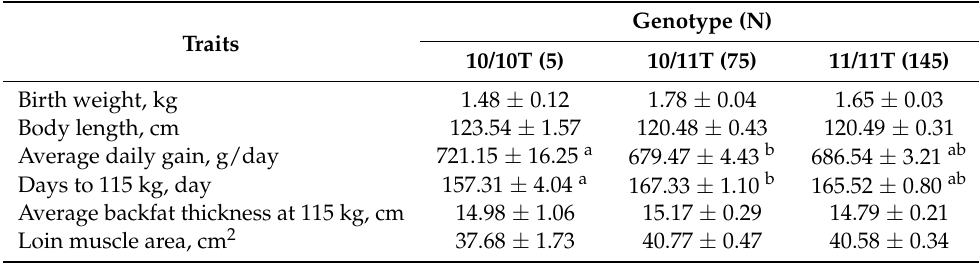
Table 6. Least-squares analysis of IGF1 genotypes and growth traits in Large White Pigs.